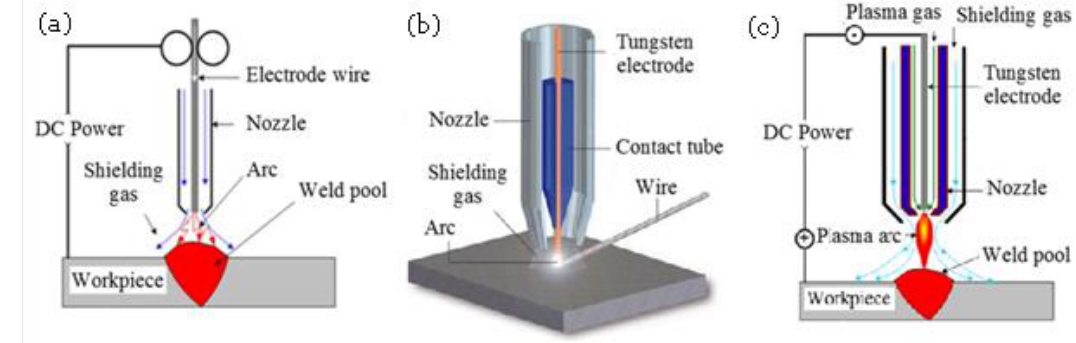
Figure 10. Schematic view of the ( a ) GMAW, ( b ) GTAW, and ( c ) PAW process [149].